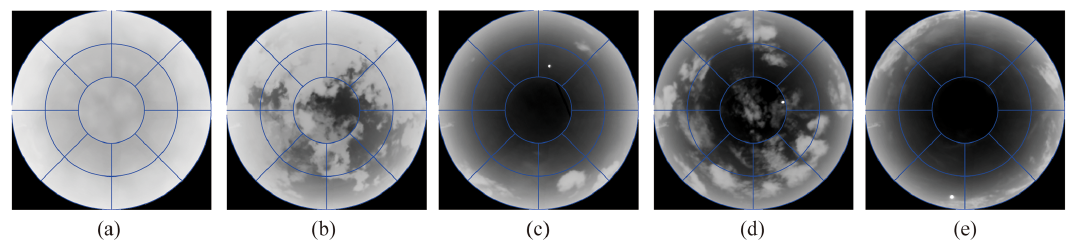
Figure 9. Selected misclassified whole-sky images: (a) stratiform clouds to waveform clouds, (b) cumuliform clouds to waveform clouds, (c) cumuliform clouds to cirriform clouds, (d) waveform clouds to cumuliform clouds and (e) cirriform clouds to cumuliform